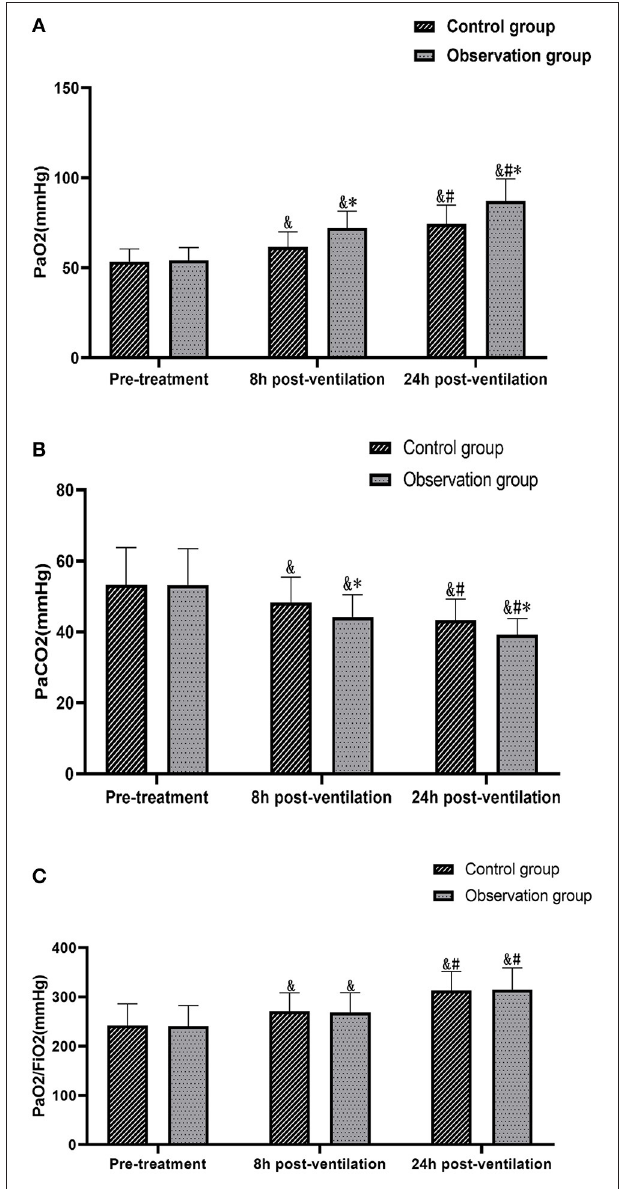
FIGURE 2 | Comparison of the changes in blood gas analysis values and oxygenation index between the two groups at different times. (A) Comparison of PaO 2 . (B) Comparison of PaCO 2 . (C) Comparison of PaCO 2 /FiO 2 . Compared with the same group pre-treatment, & P < 0.05. Compared with the same group 8h post-ventilation, # P < 0.05. Comparison with control group over the same period, * P